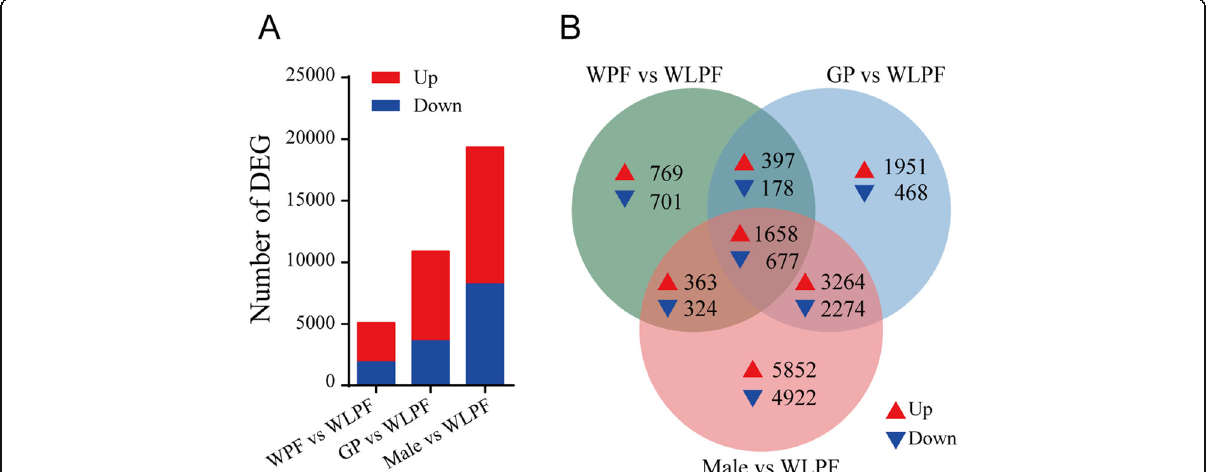
Fig. 4 Pairwise comparison of DEGs between wing and wingless morphs. a Number of DEGs in the paired comparison between winged morphs and WLPF. DEGs between WPF and WLPF were from a recent study (Ji et al. 2019). b Distribution of DEGs in the pairwise comparison between wing and wingless morphs. WLPF, wingless parthenogenetic female; WPF, winged parthenogenetic female; GP, gynopara; Up, upregulated; and Down,